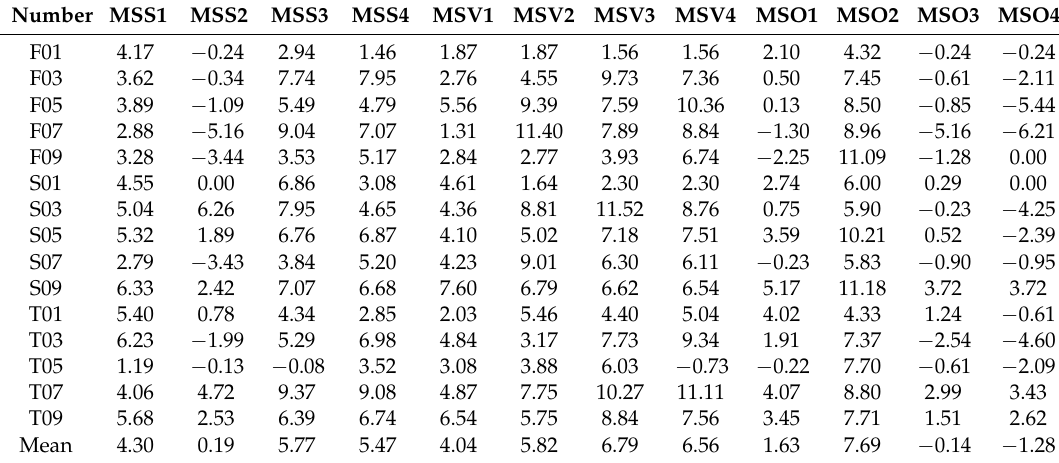
Table 5. The effect of twelve transfer functions on the performance of discrete MS algorithm ( RPD